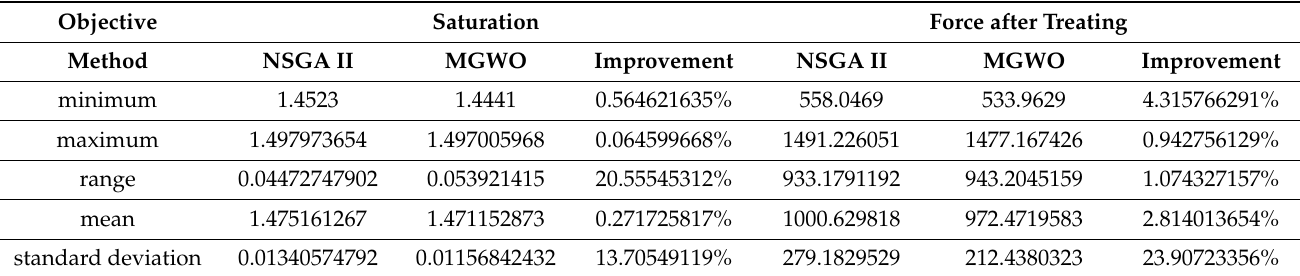
Table 8. MGWO versus NSGA II for TLSM design under third